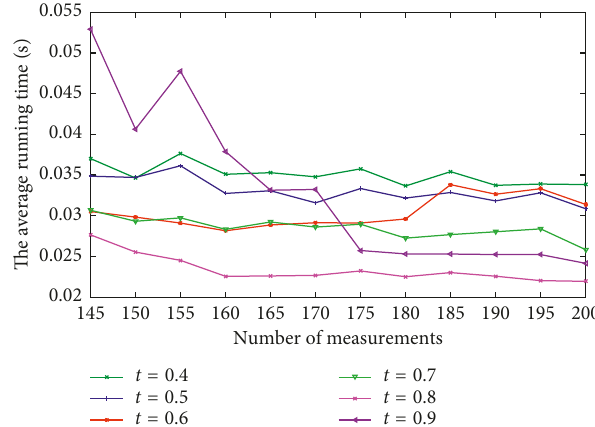
Figure 2: Reconstruction probability of different thresholds with different measurements in different sparsity conditions ( n t 0 . 1 1 . 0 , s 8 , 12 , 16 , 20 , Gaussian [ ] [ ] ∈ ∈